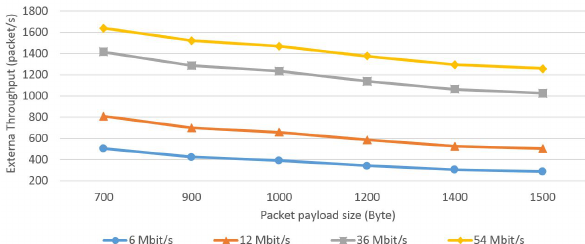
Figure 14: Channel throughput rate for external pairs in Scenario 3.